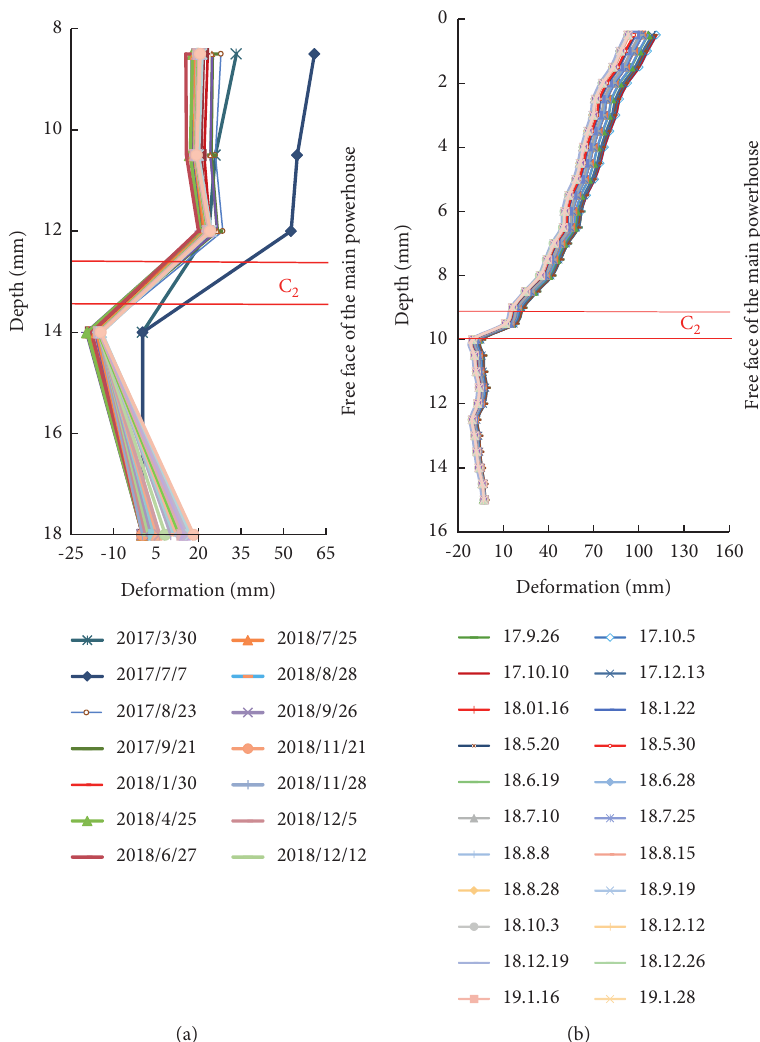
Figure 12: The curves of shear deformation with depth measured by inclinometers in the omnibus bar caves: (a) IN (b) IN ZMD4 -0 +025-1. Table 4: Deformation and failure issues and the corresponding poor geological structures in different hydropower stations [9, 36–41]. Project name